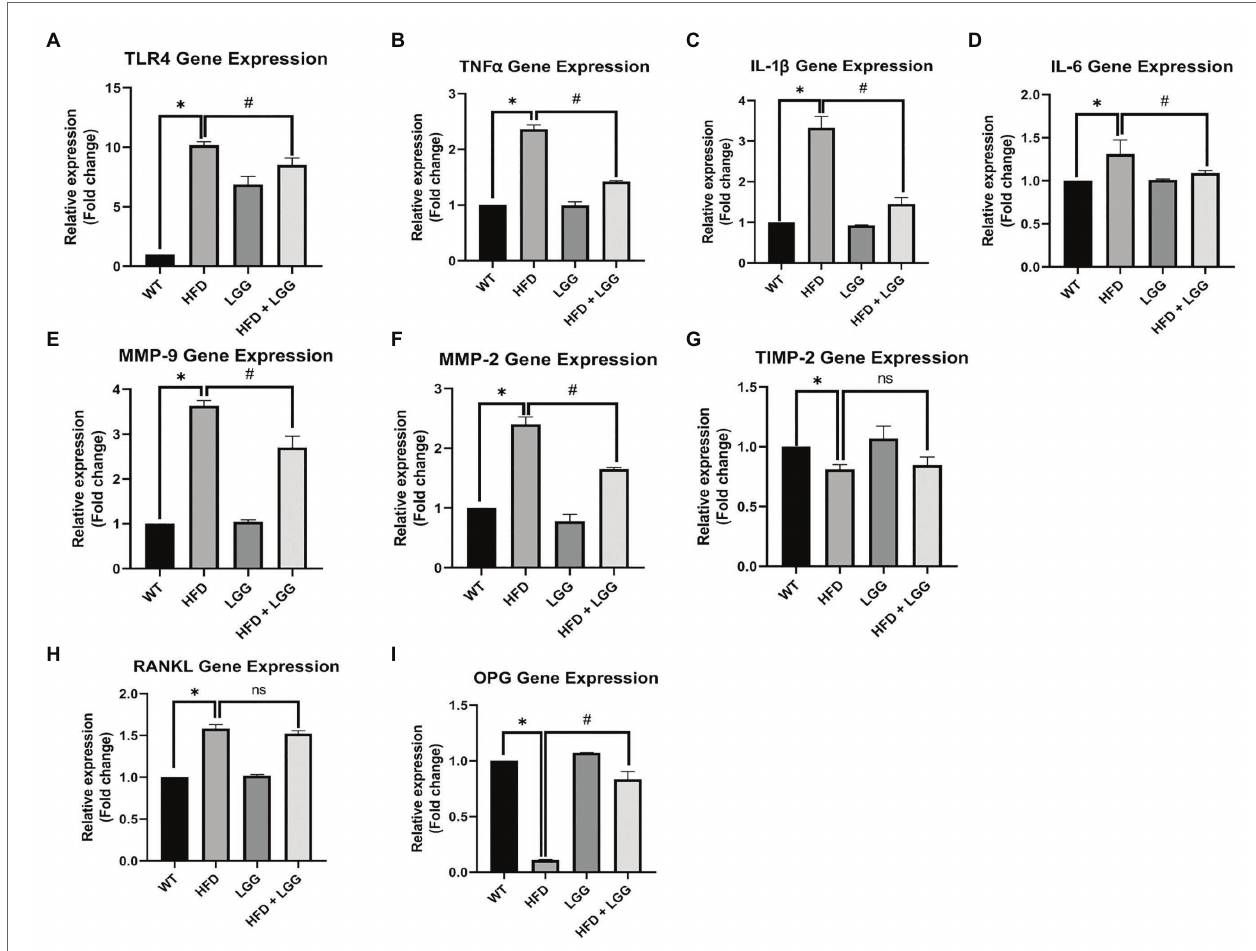
FIGURE 5 | Effect of HFD and LGG treatment on the molecular remodeling in periodontal tissues. WT, Wild-type C57BJ/L6 mice; HFD, HFD-supplemented wild- type mice; LGG, LGG-supplemented wild-type mice; HFD + LGG, HFD, and LGG-supplemented wild-type mice. Quantitative RT-PCR analysis for (A) TLR 4 , (B) TNF α , (C) IL-1 β , (D) IL-6, (E) MMP-2, (F) MMP-9, (G) TIMP-2, (H) RANKL, and (I) OPG mRNA expression. The results are presented as the expression of the individual mRNAs with normalization GAPDH, using the 2 − Δ ΔCq method. All data represent means ± SD, Fold change vs. WT group. All data represent means ± SD, WT vs. HFD group * p < 0.05; HFD vs. HFD + LGG; ns p > 0.05, HFD vs. HFD + LGG # p < 0.05, n =